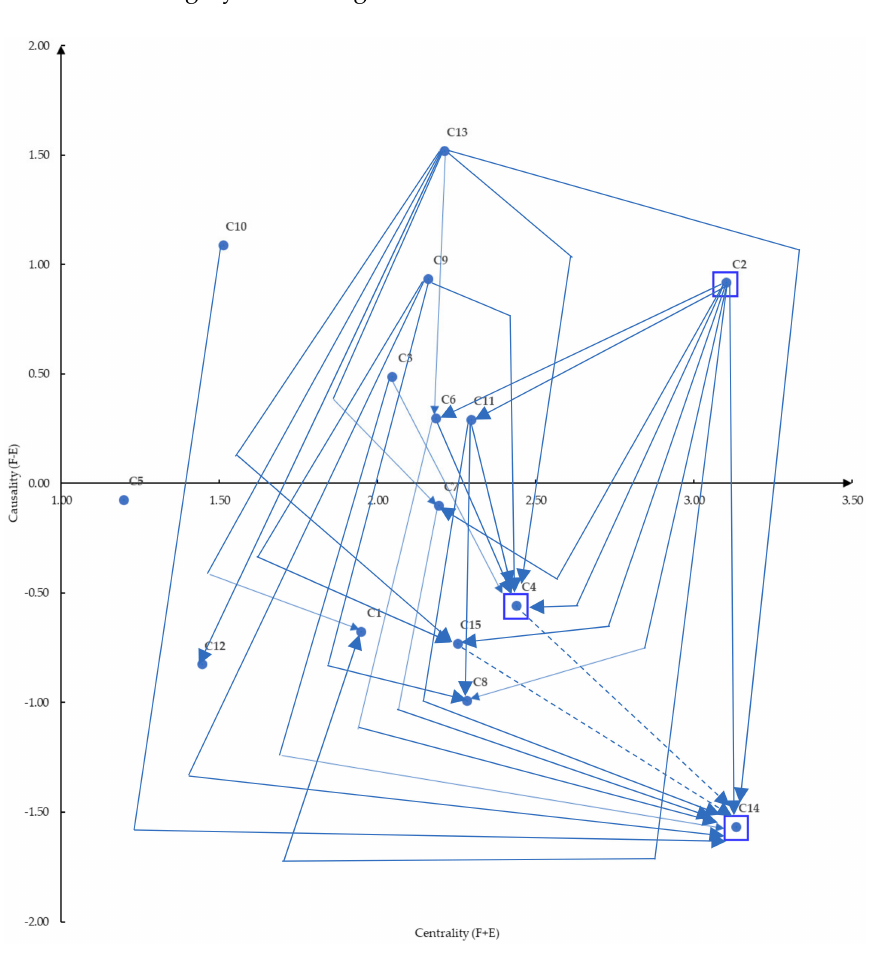
Figure 3. Prominence and cause–effect